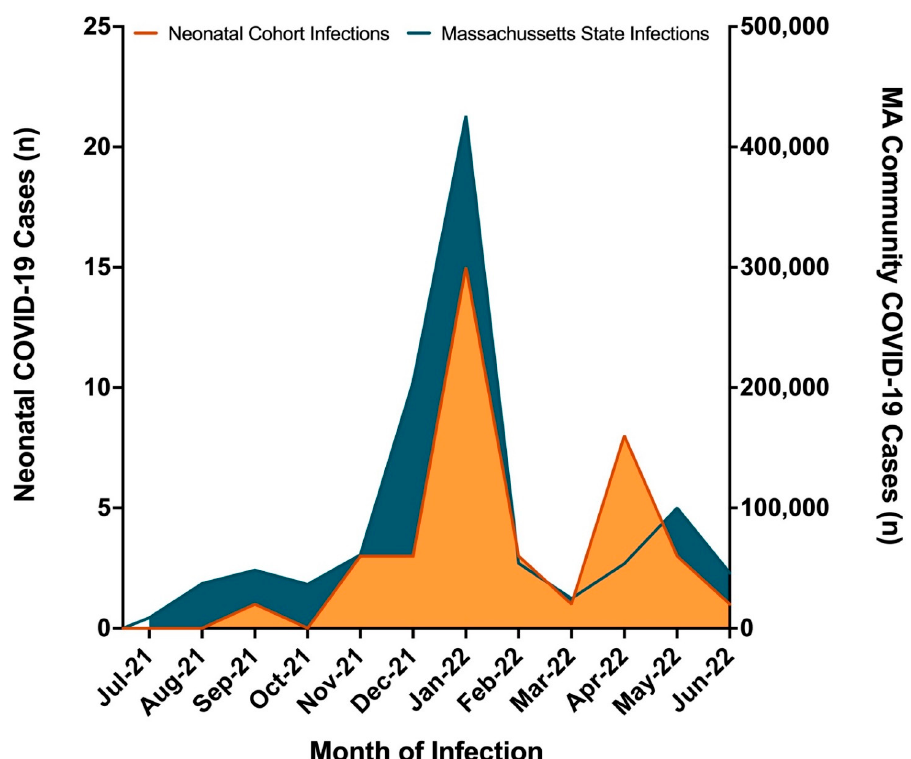
Figure A1. Cases of neonatal COVID-19 in the context of community case rates. Number of reported community SARS-CoV-2 infections in Massachusetts (MA) (right axis) and reports of infant infections in our infant cohort (left axis). Infant cases of COVID-19 in our study align with cases in MA community, suggesting community spread contributes to an infant’s susceptibility to SARS-CoV-2 infection. MA community COVID-19 case data extracted from MA Department of Public Health [27].